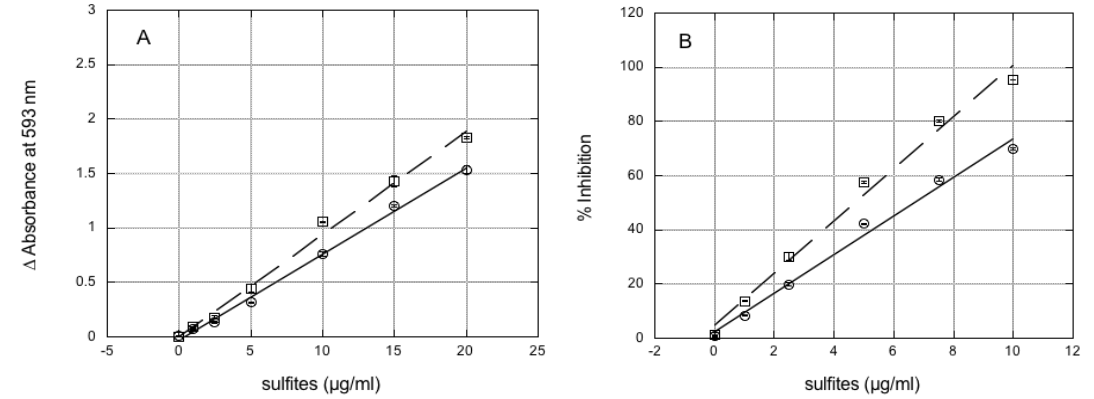
Figure 2. Reaction of sodium sulfite and sodium metabisulfite in the FRAP and ABTS assays. FRAP ( A ) and ABTS ( B ) assays were carried out with increasing amounts of either sodium sulfite (open circles) or sodium metabisulfite (open squares). Data are means of three replicates ± SE.